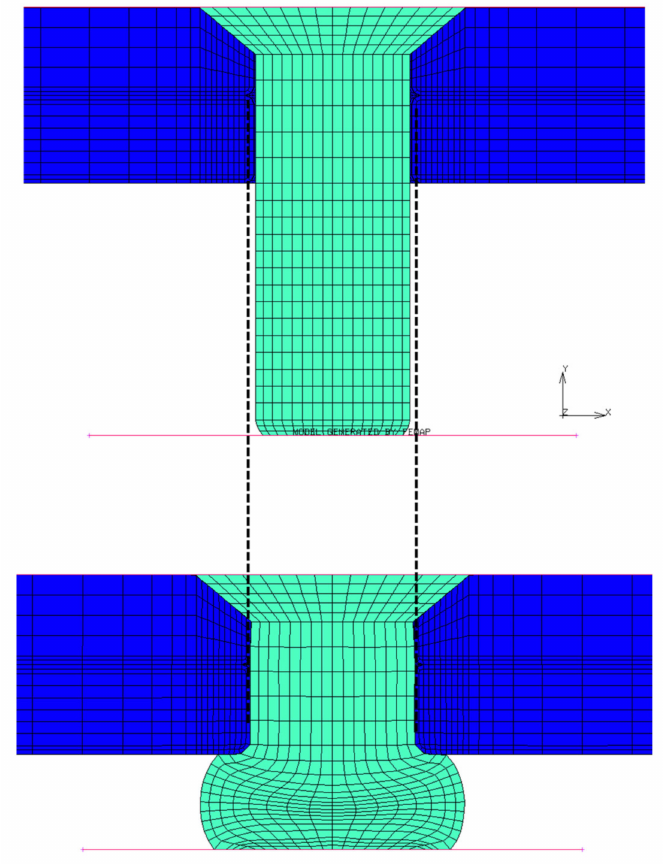
Figure 11. Change in cross-sectional area of rivet shank after squeezing where Fsq = 19.5